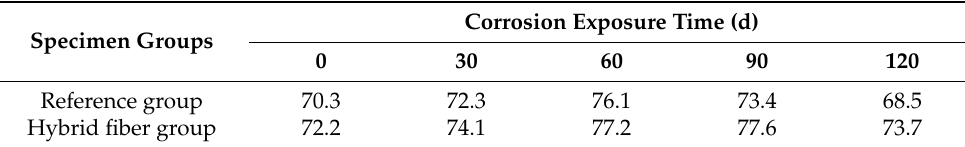
Table 11. Results of compressive strength after sulfate corrosion